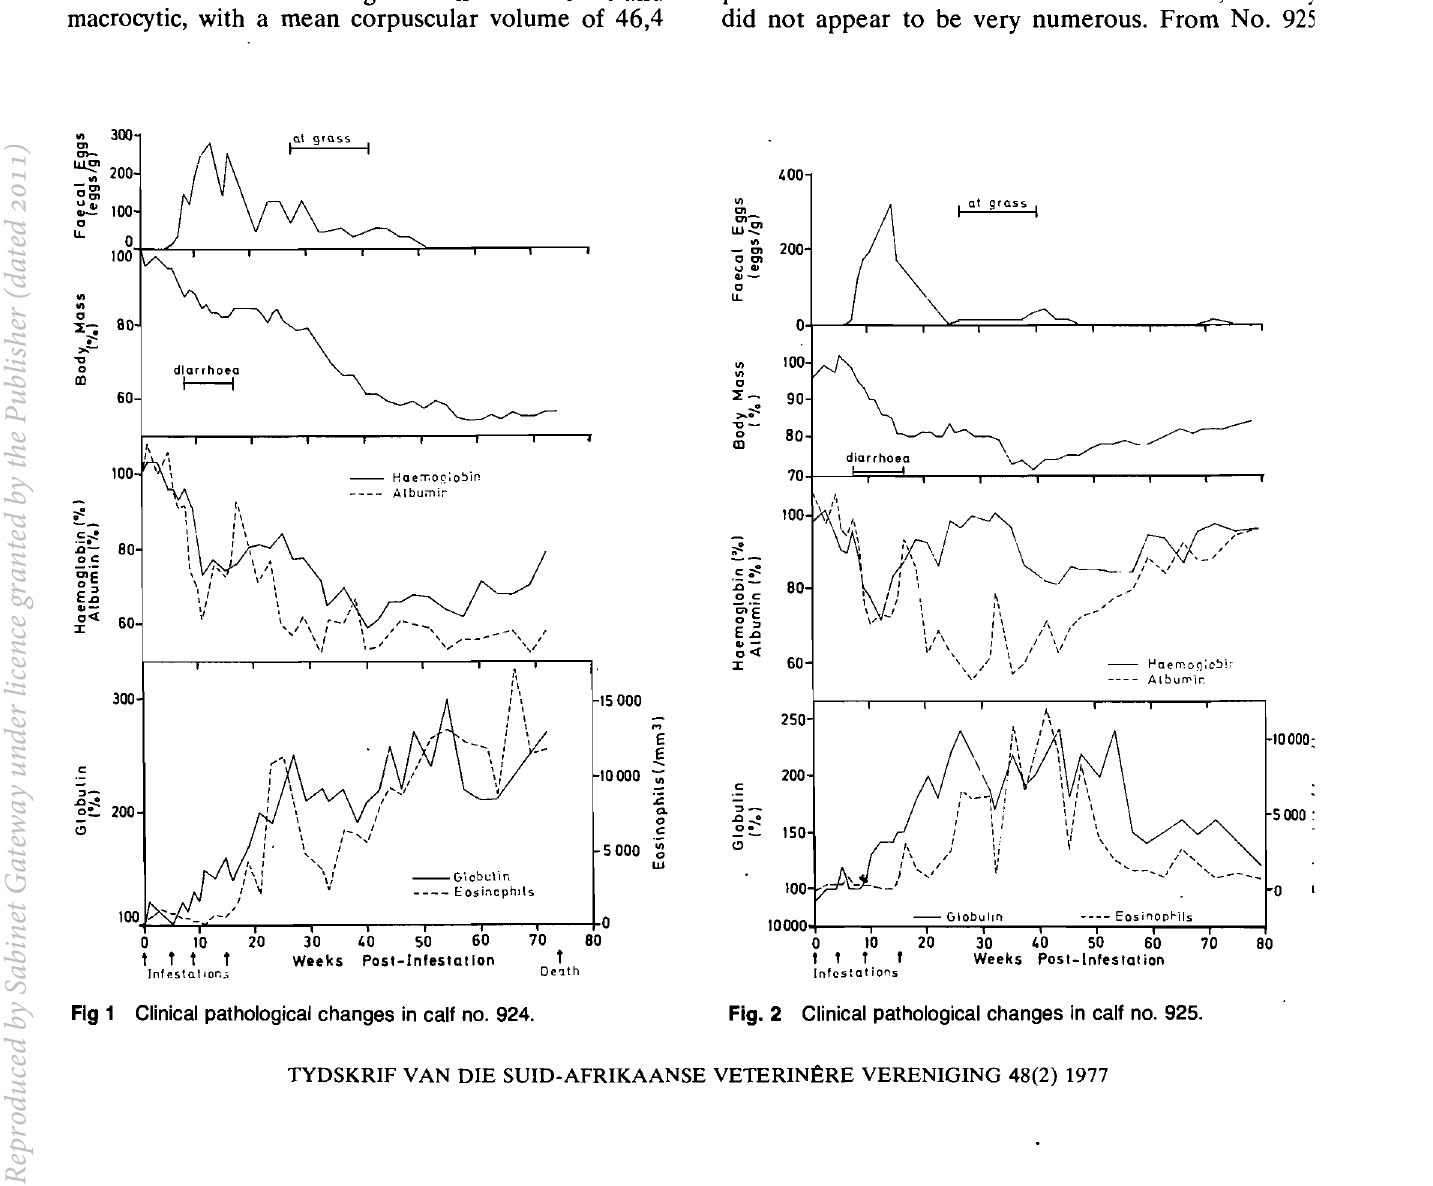
Fig 1 Clinical pathological changes in calf no. 924, Fig. 2 Clinical pathological changes in calf no.